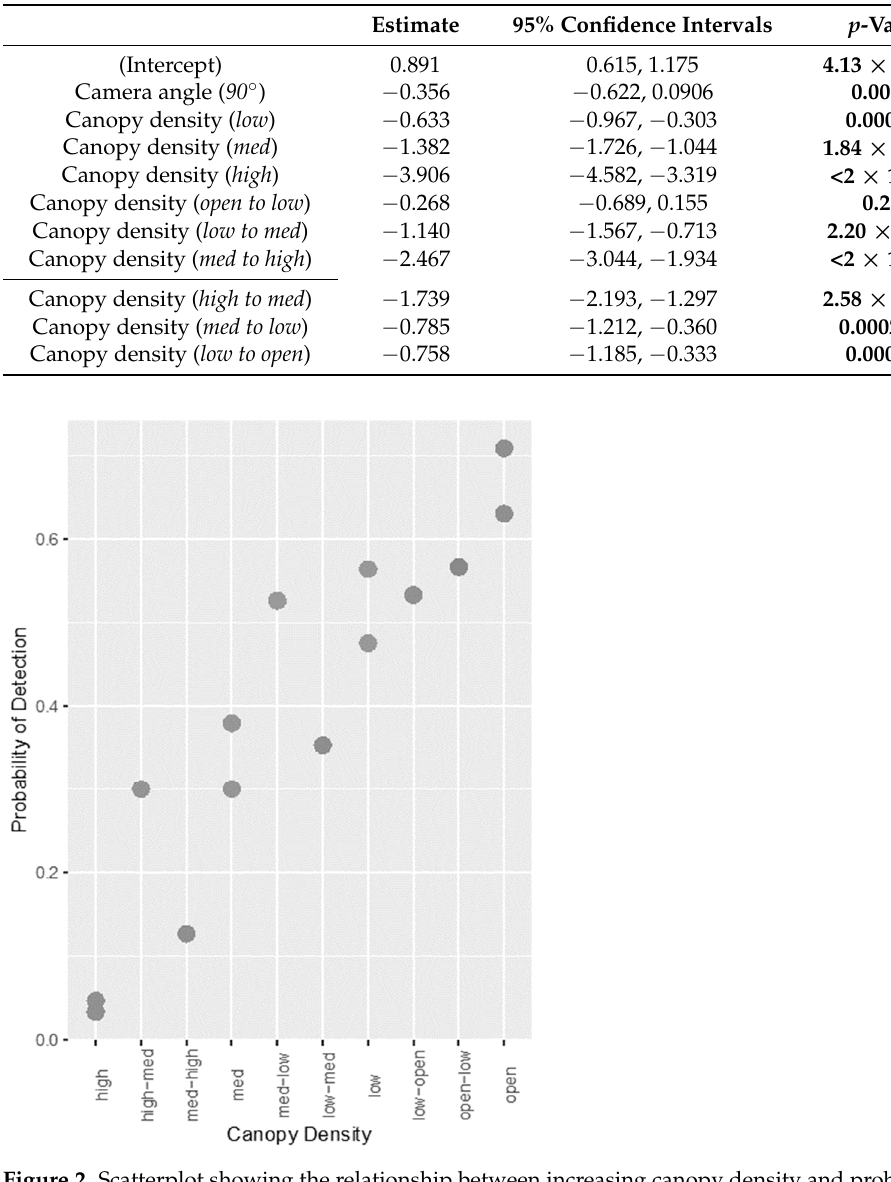
Figure 2. Scatterplot showing the relationship between increasing canopy density and probability of detection for RGB images with manual detection.